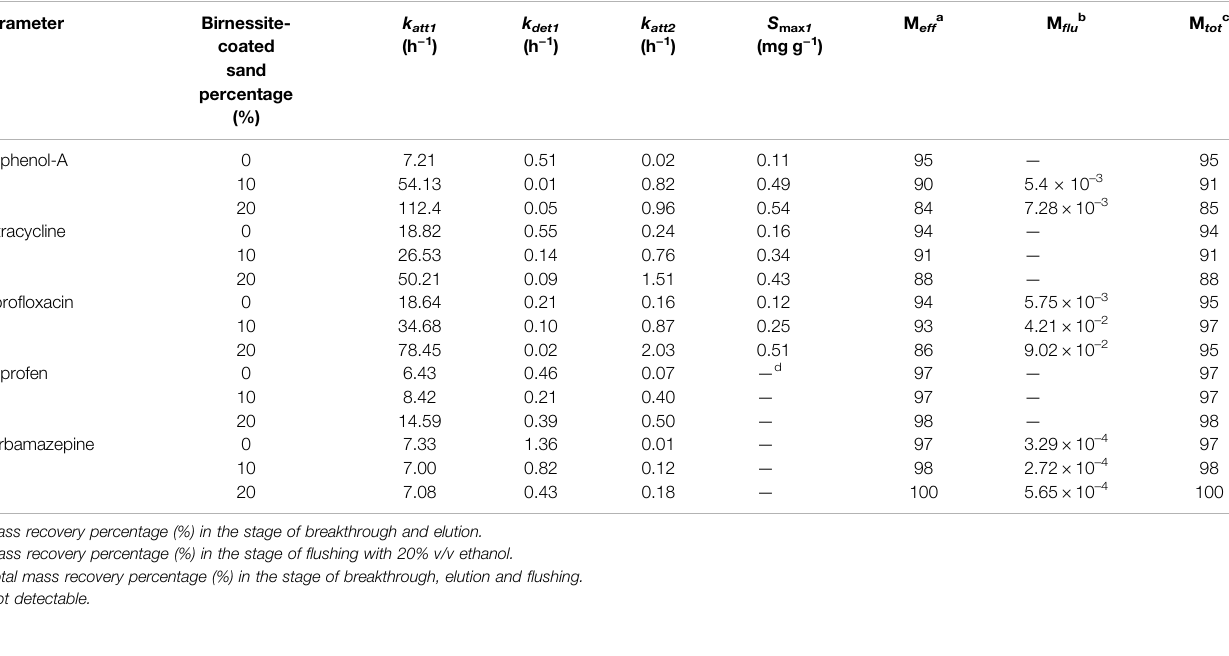
Frontiers in Environmental Science |